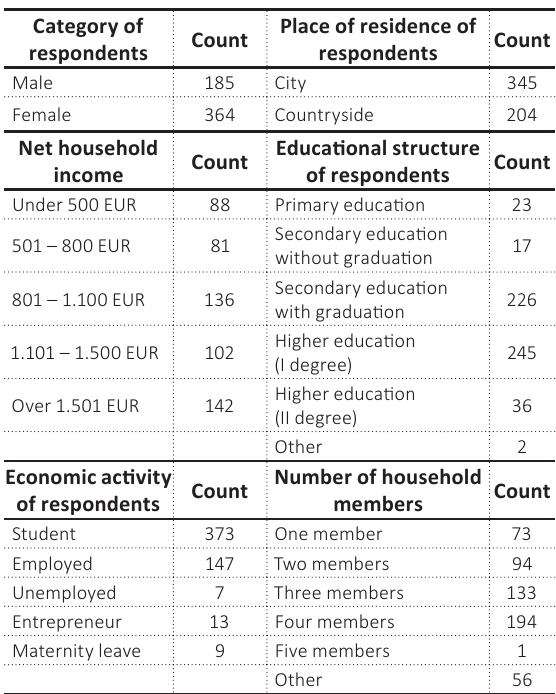
Table 1. Characteristics of respondents